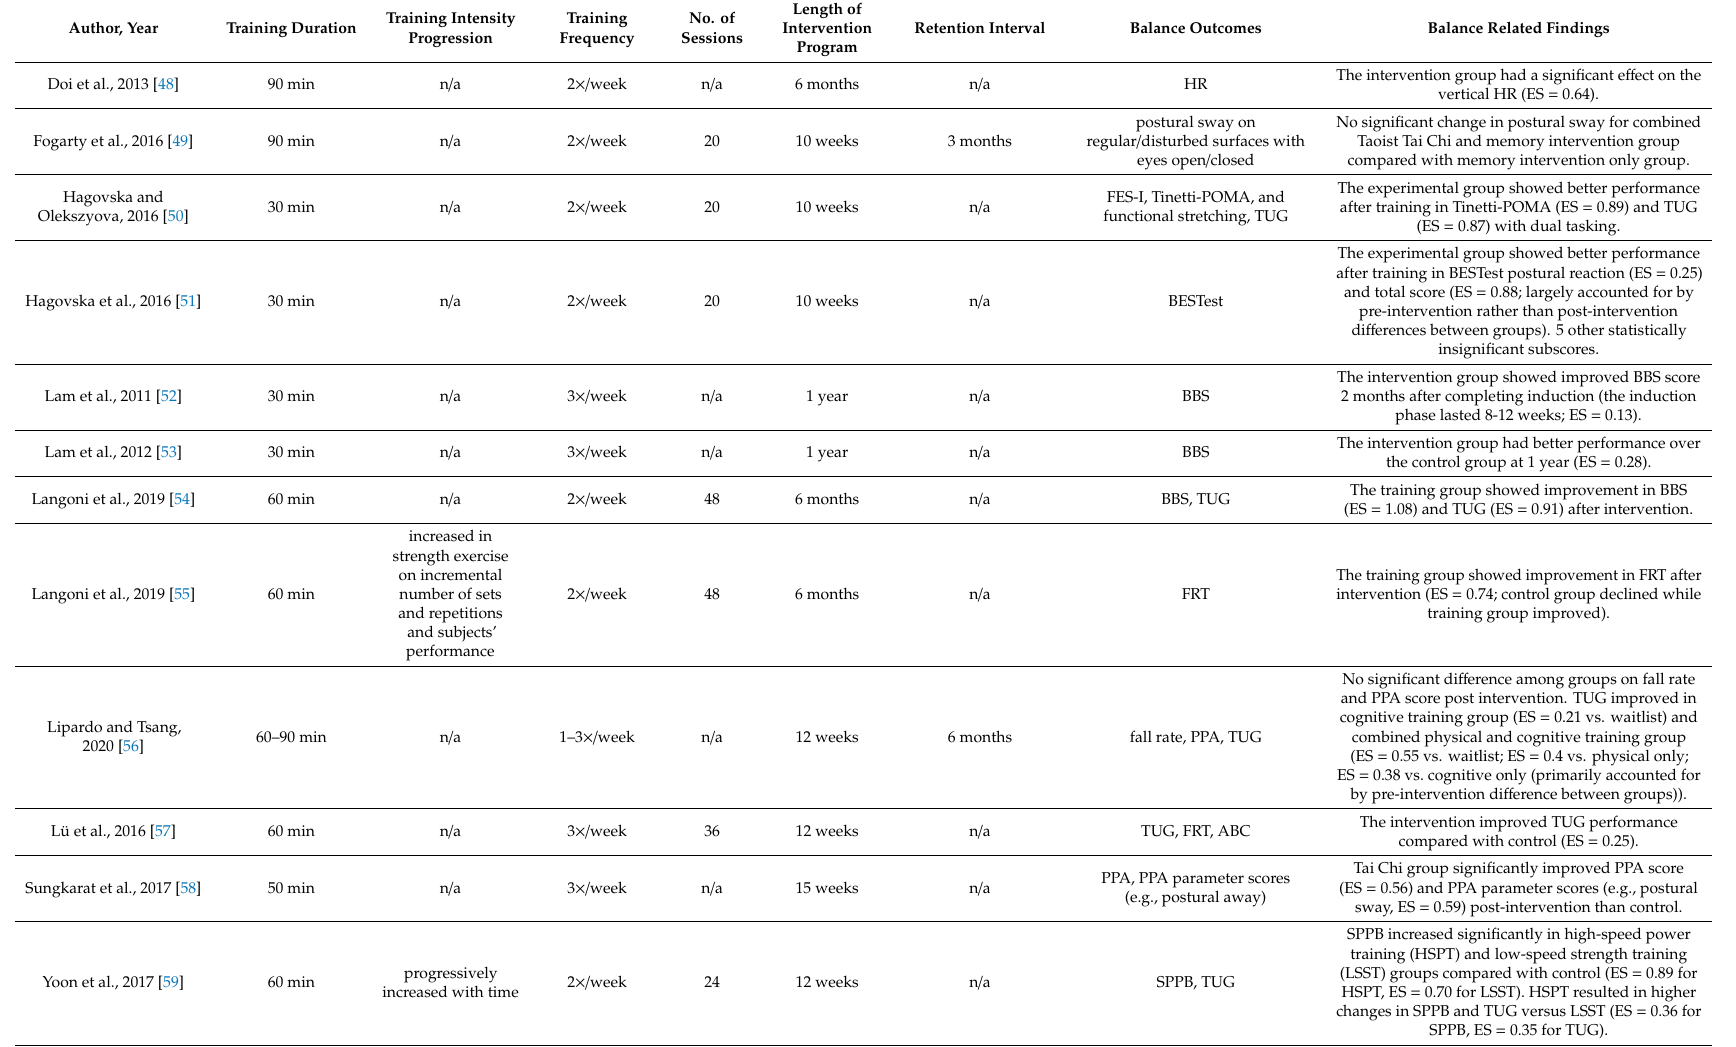
(ES = 0.87) with dual tasking. The experimental group showed better performance after training in BESTest postural reaction (ES = 0.25) and total score (ES = 0.88; largely accounted for by pre-intervention rather than post-intervention di ff erences between groups). 5 other statistically insignificant subscores.